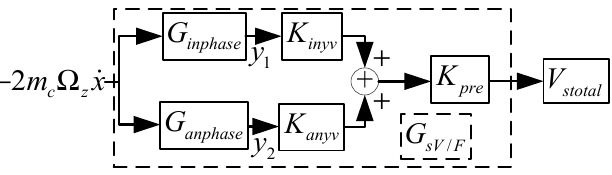
Figure 3. The real working model schematic diagram of the sense mode.